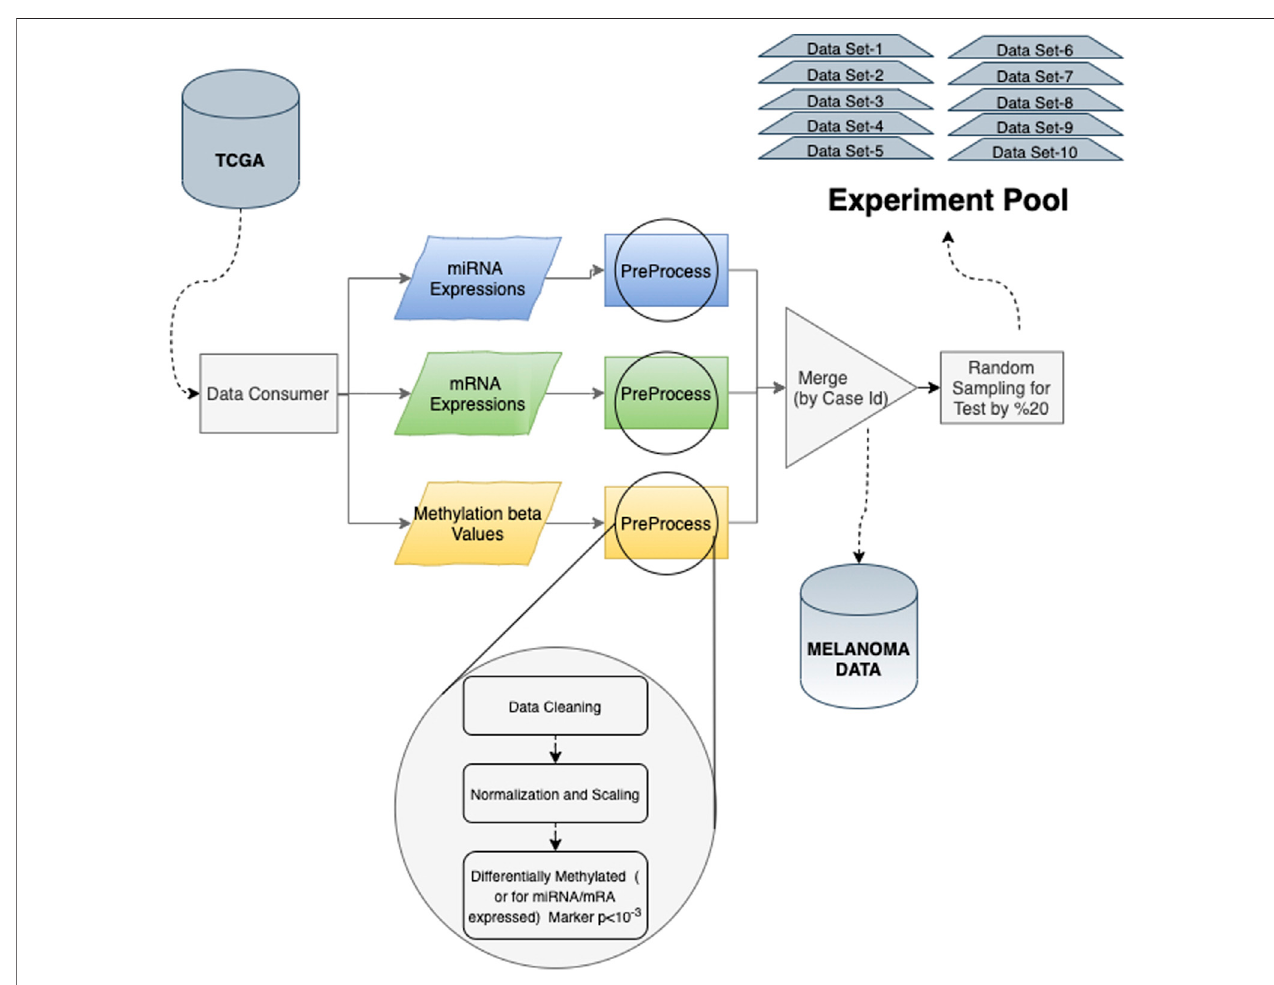
FIGURE 1 | Experimental pool generation process: each method is evaluated using a sample experimental pool under the same circumstances. miRNA, mRNA, and methylation data consumed through TCGA were processed separately and merged to generate the whole melanoma marker dataset. Then, through random splinting, 10 individual sample datasets are constructed. Each random split is saved by applying both undersampling and oversampling (SMOTE) techniques.